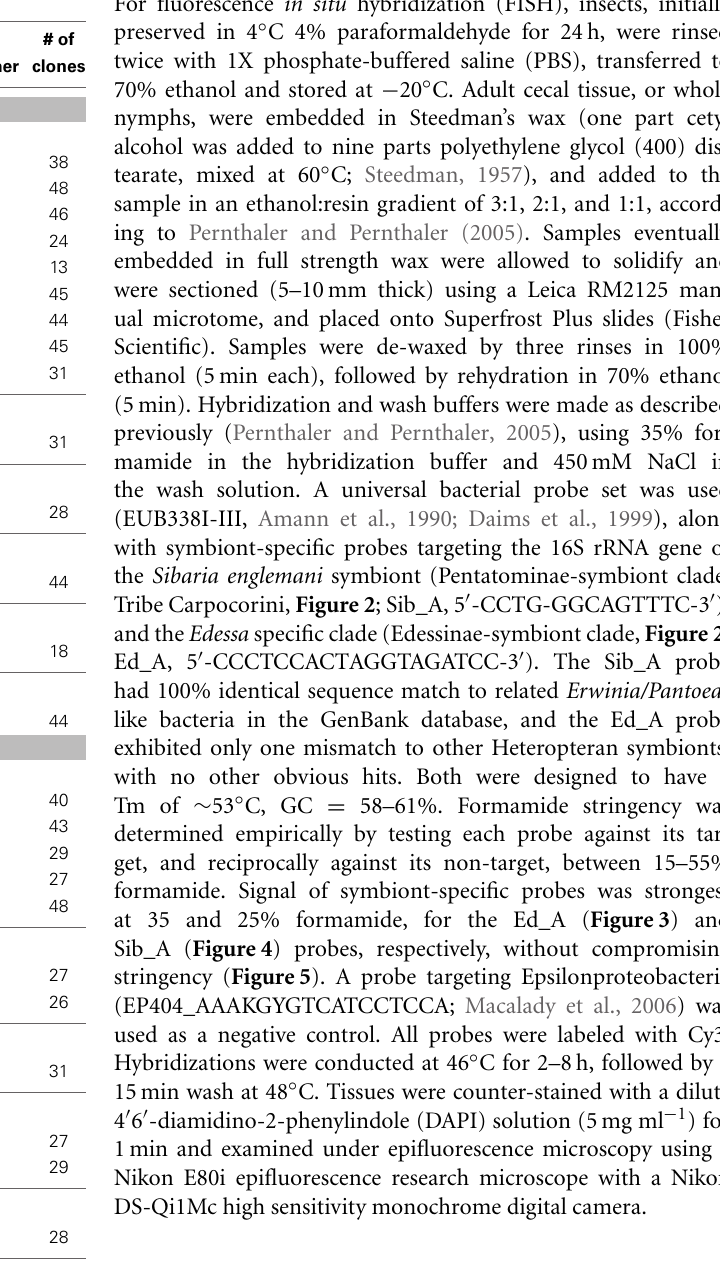
Table 1 | Summary of bacterial 16S rRNA clone library results for all